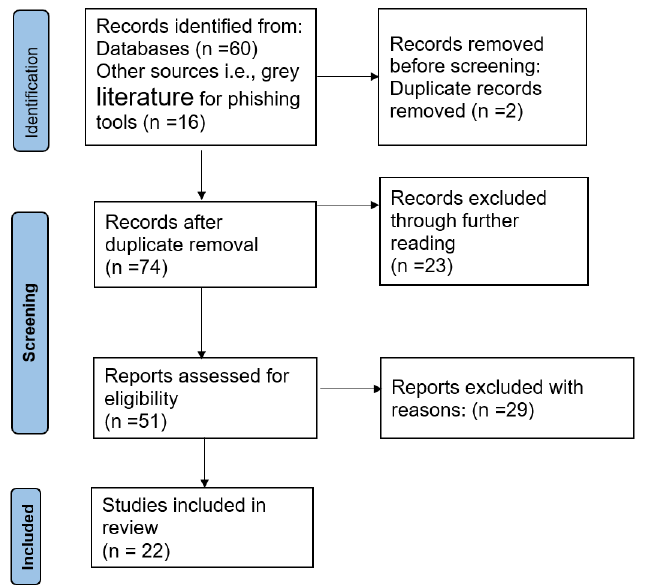
Figure 5. Report of literature: PRISMA diagram